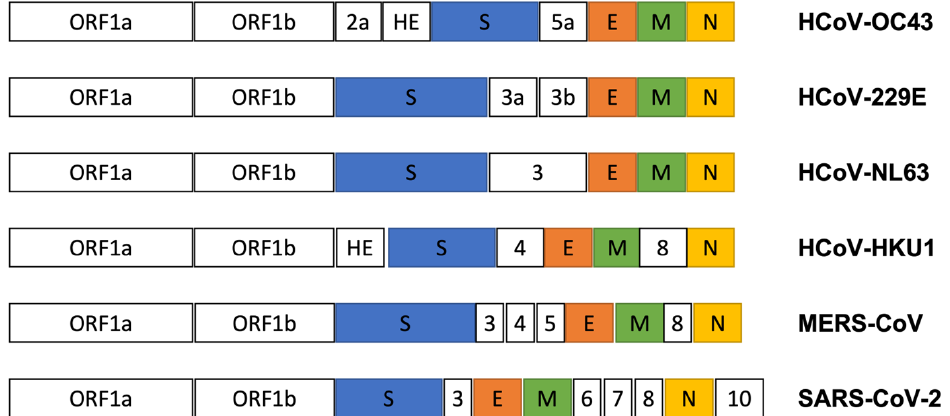
Figure 2. Comparison of abbreviated genomic maps of HCoV-OC43 with other coronaviruses including HCoV-229E, HCoV-NL63, HCoV-HKU, MERS-CoV, and SARS-CoV-2 (not to the scale). Used acronyms are as follows. ORF; open reading frame, HE; hemagglutinin-esterase, S; spike, E; envelope, M; membrane, N; nucleocapsid. Number-only genes (2a, 5a, 3a, 3b, 3, 4, 5, 6, 7, 8, 10) indicate nonstructural genes. Some in-between nonstructural genes from SARS-CoV-2 were not shown for purposes of better comparison.